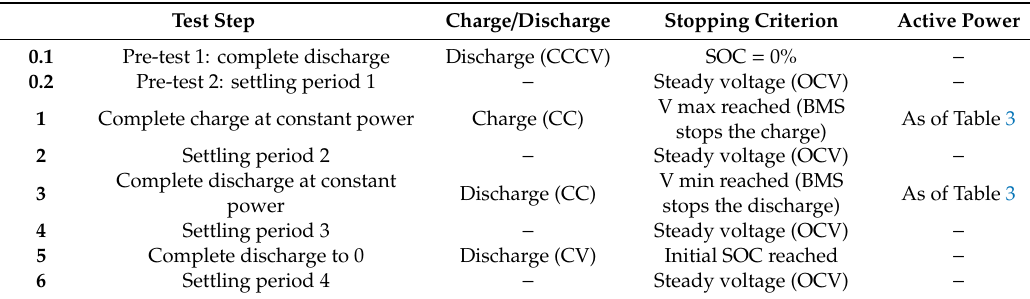
Table 4. Test steps for Set 1.